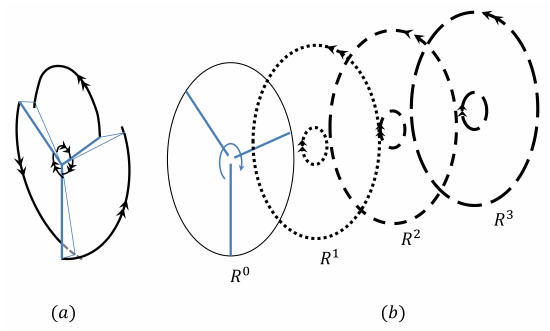
Figure 4. Schematic representation of a four vortex rings ( b ) shed by the far wake model ( a ). The Propagation of Vortex